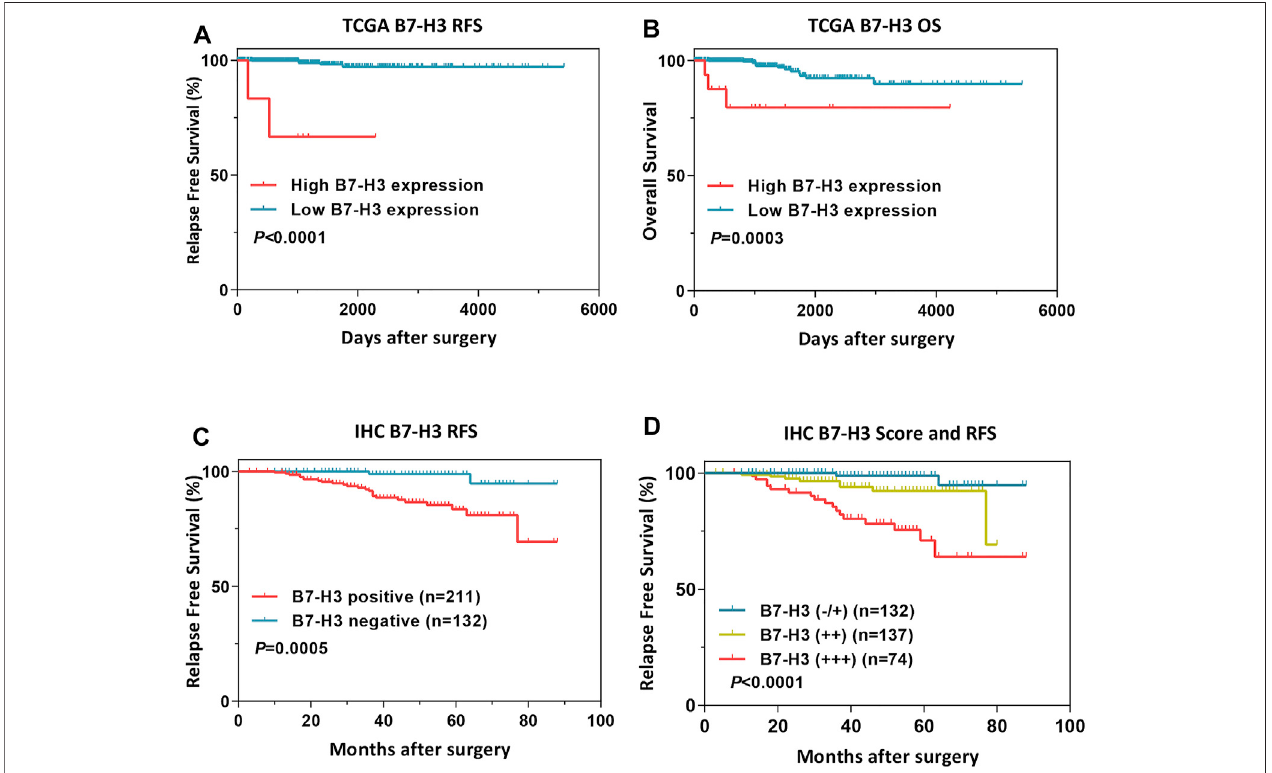
FIGURE4| SurvivalanalysisofB7-H3 inPTC ofTCGA dataset (A,B) .B7-H3 survivalanalysisinPTC ofIHC (C,D) .Survivalanalysisbased onB7-H3expression in clinical subgroups (E – P) . p < 0.05 is considered to be statistically signi fi cant., ,